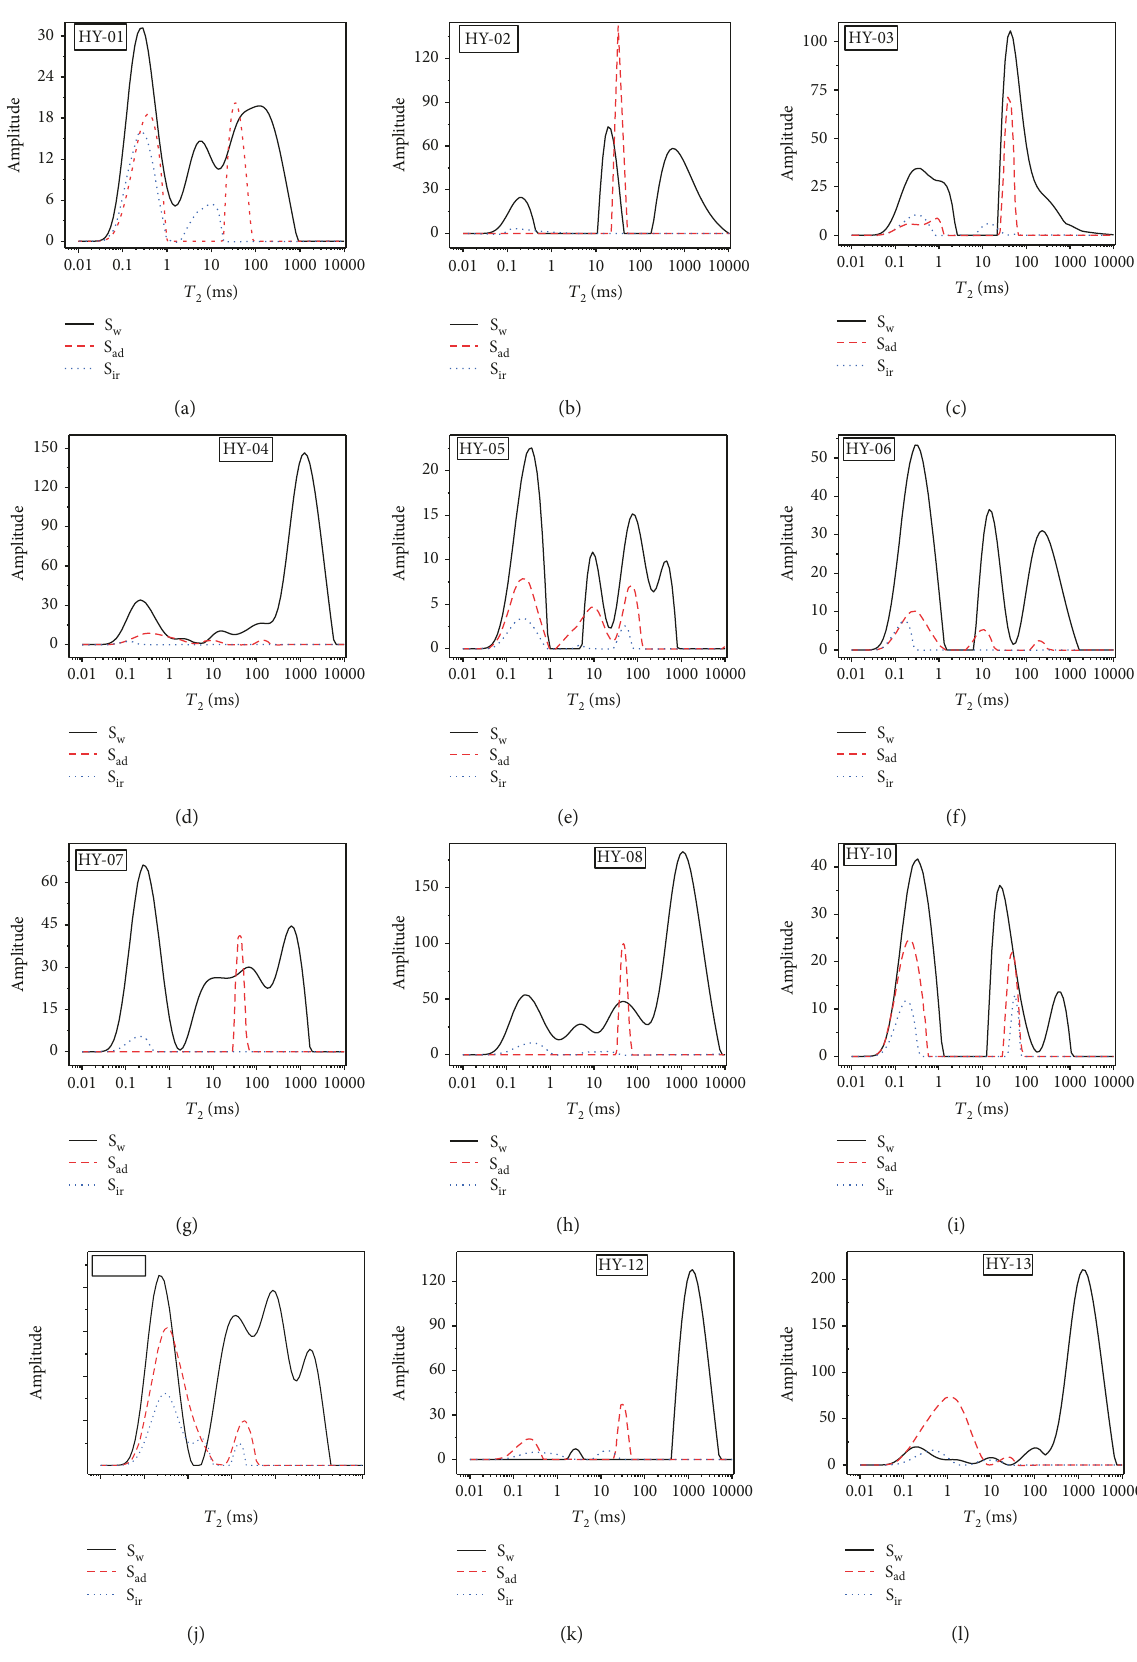
Figure 5: NMR T 2 distribution after microwave treatment with various water